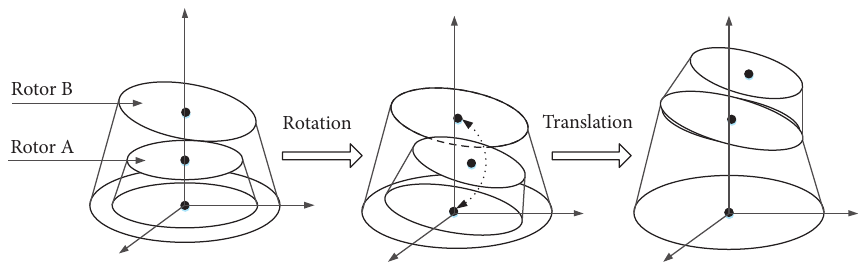
Figure 1: The assembly process of a two-stage rotor.